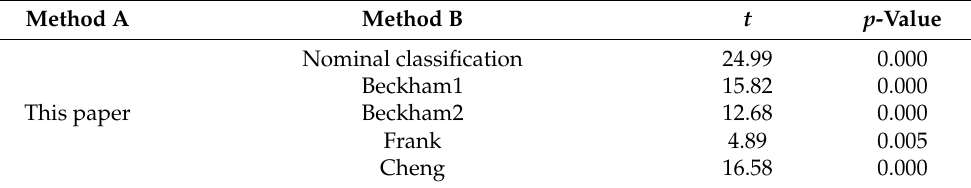
Table 7. Paired Student’s t -test